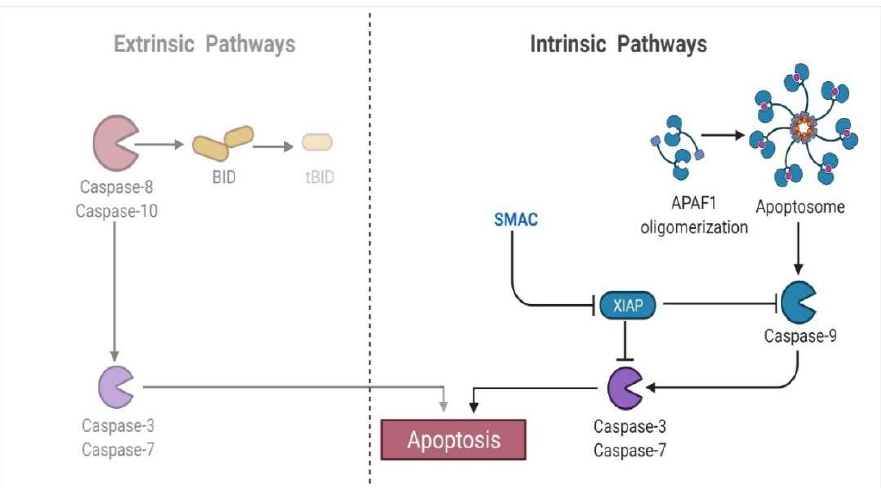
Figure 7. The executioner caspase proteins (e.g., Caspase-3, Caspase-7) trigger apoptosis in both extrinsic and intrinsic pathways.